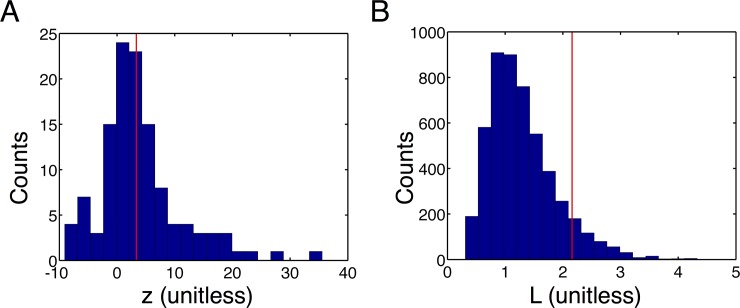
Enrichment of behavior related sequences.(A) The histogram of standardized log-likelihood ratios of all ‘RUN-order’ sequences for Rat 2 shows enrichment of subsequeces of the RUN word. The RUN sequence for Rat 2 was 1-2-3-4-5-6-7 (see Fig 3), and RUN-order sequences are any sequence in which cells fire in this order, but with gaps (e.g. 1-3-5-7). There are 120 such sequences and 55 of them are significantly enriched (see Table 3) indicating significant enrichment for sequences in RUN-order. The vertical red line indicates the significance level p < 0.05 with a Bonferroni correction for multiple hypothesis testing. (B) The histogram of likelihood ratios of all 5040 permutations of the RUN sequence for Rat 2 shows that the RUN sequence has a likelihood ratio in the 9th-percentile of this distribution (vertical red line), indicating that it is strongly enriched relative to other comparable sequences in the ensemble firing. Note that this distribution shows both up- and down-regulation of place cells sequences in the fitted model indicating that the sequential structure in the fitted model does prefer for place cells to fire in certain orders and not others. Thus, the enrichment of the RUN sequence cannot be attributed to a general up-regulation of arbitrary sequences of these place cells.